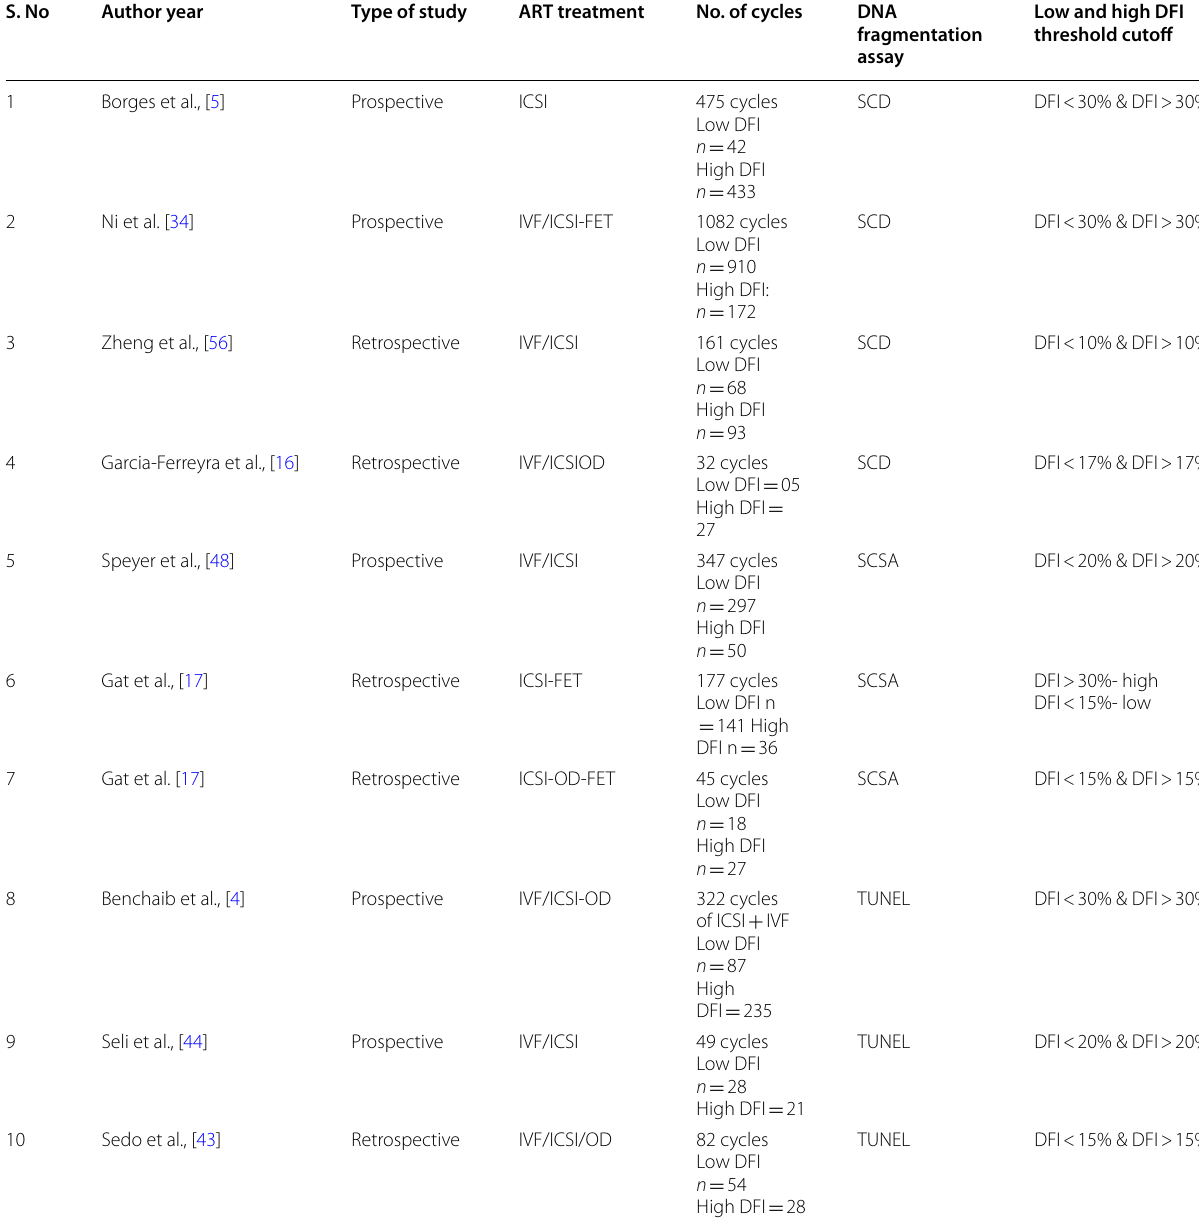
Table 1 Study characteristics (included studies) S.